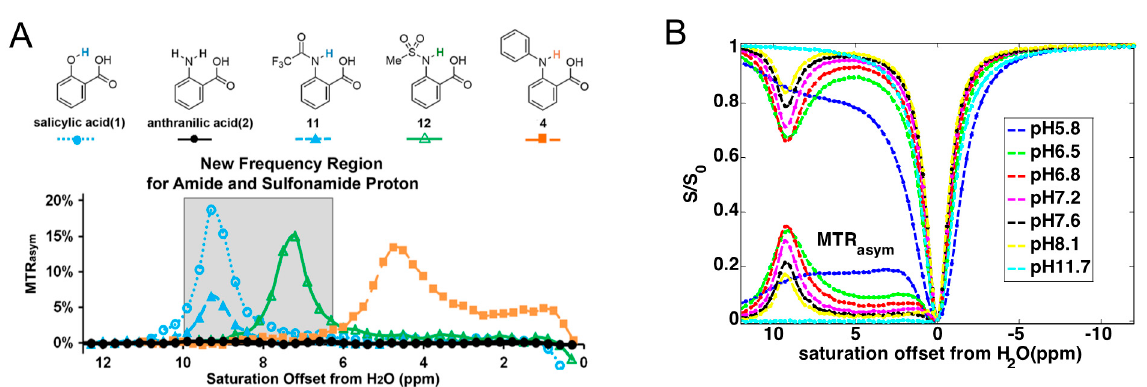
Figure 7. CEST MRI contrast of salicylic acid ( A ). CEST contrast curves for representative salicylic acid (1) and anthranilic acid derivatives (2, 4, 11 and 12) at concentrations of 25 mM (pH 7.1–7.4) using B 1 = 3.6 µT, T sat = 3 s. The gray box indicates this group of agents includes a new frequency region for amide and sulfonamide protons. Reprinted with permission from [136]. ( B ) pH effect on the contrast of salicylic acid at pH = 5.8–11.7. Concentration = 25 mM, and B 1 = 7.2 µT. Maximal contrast was observed between pH 6.5 and 7.0. Reprinted with permission from Ref [91].